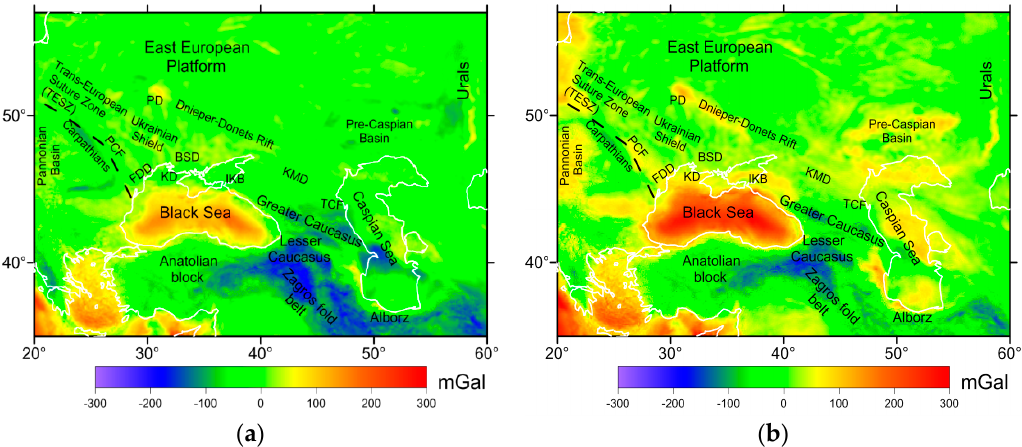
Figure 2. ( a ) Bouguer gravity anomalies; ( b ) residual gravity field after removal of the effect of the initial density model of the sedimentary cover. See text for detailed explanations.